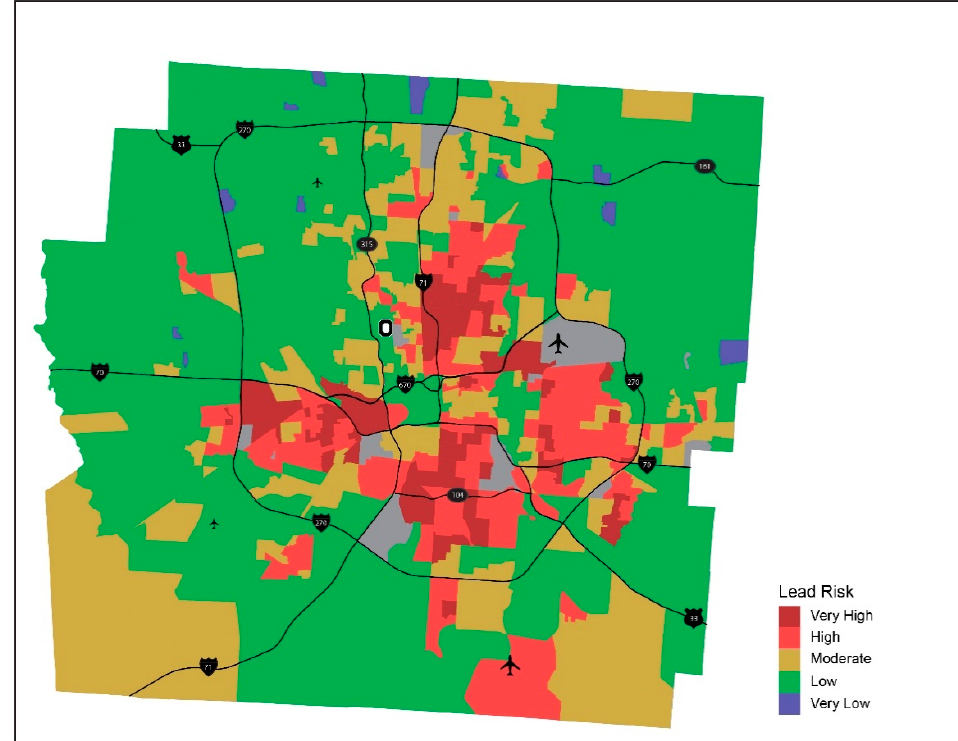
Figure 4. Lead risk by census block group—Franklin County, Ohio.